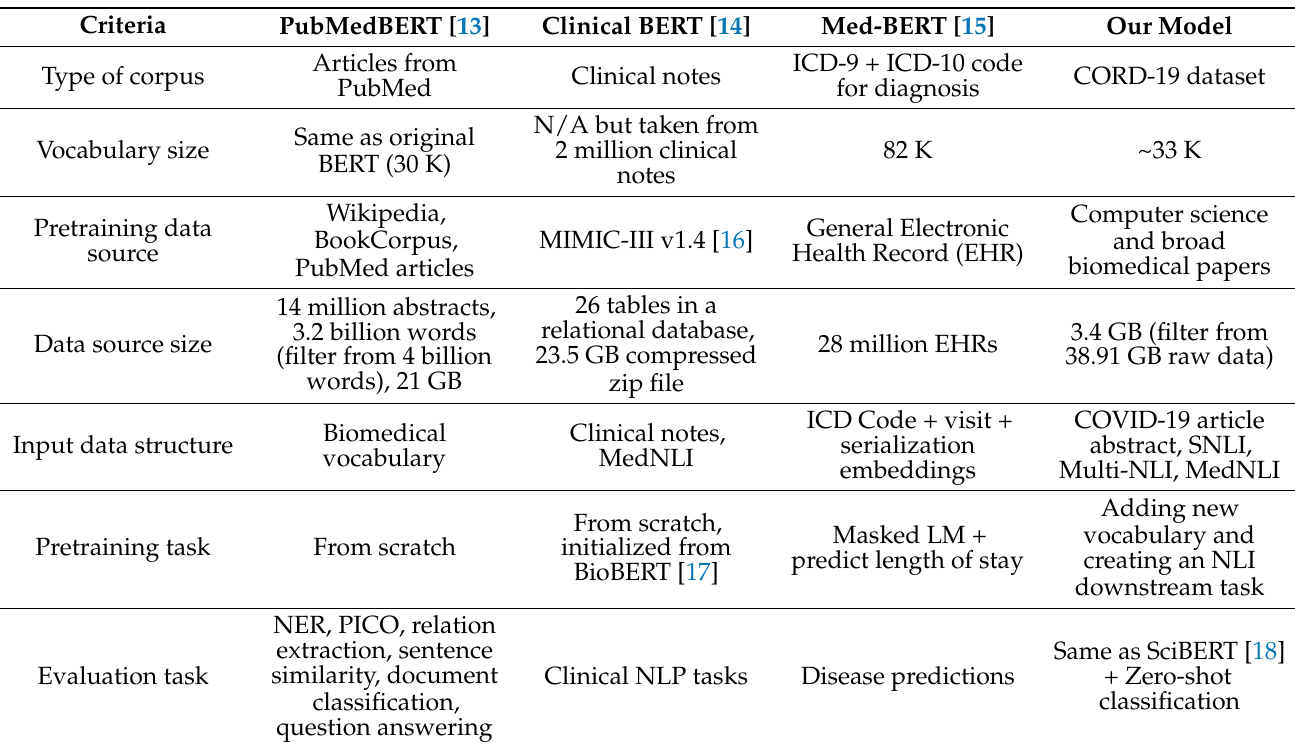
Table 2. Comparison of biomedical BERT-based